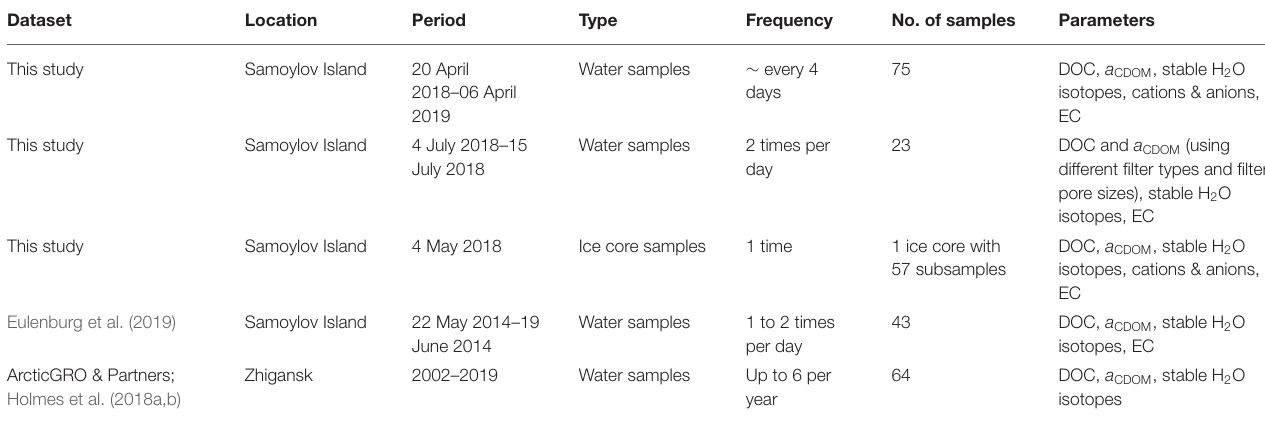
TABLE 1 | Sampling period, frequency, sample type and measured parameters of datasets used in this